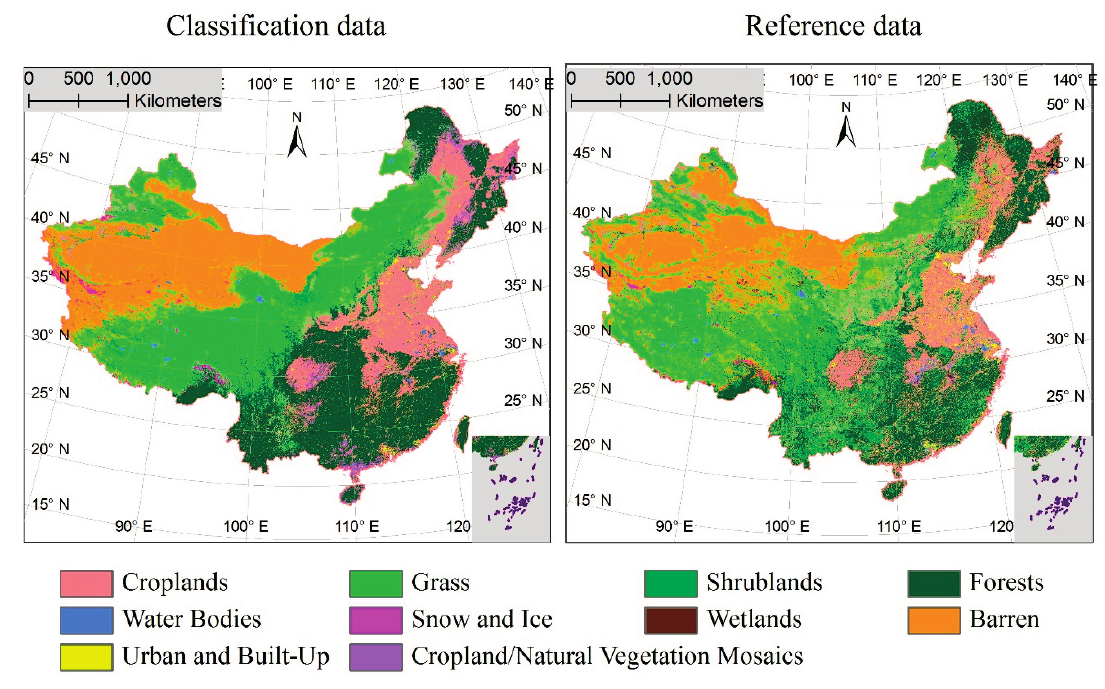
Figure 1. Classification and 100-m reference data after